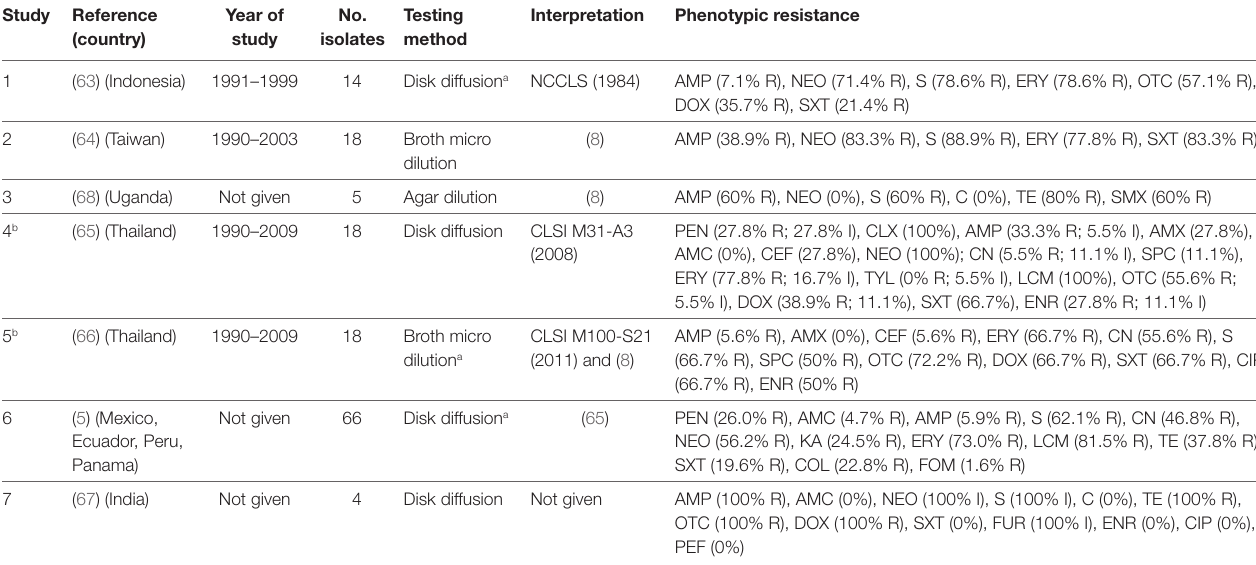
TABLe 4 | Summary of results of 7 phenotypic studies on antimicrobial resistance of A. paragallinarum from poultry. Study Reference